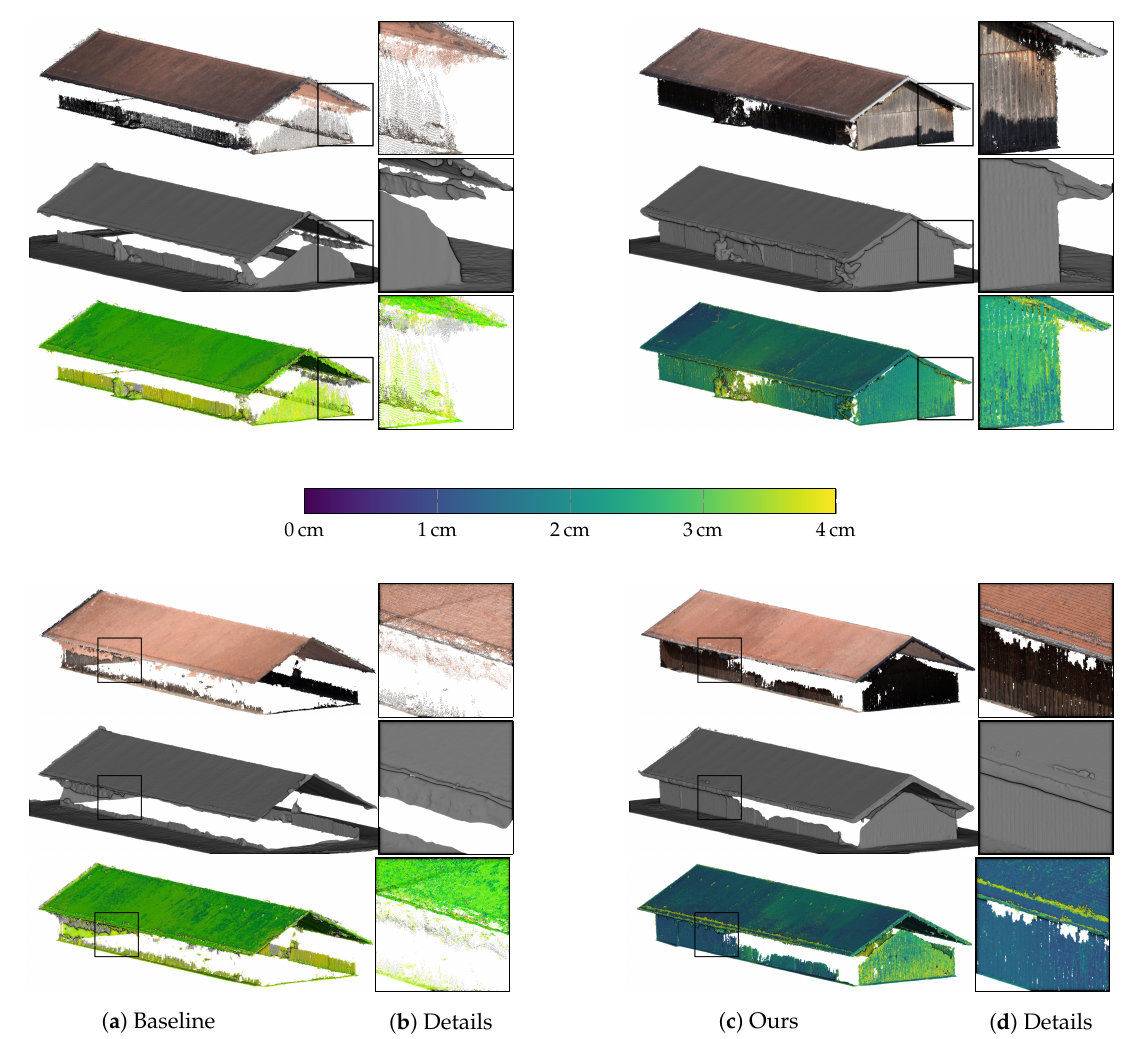
Figure 14. Qualitative reconstruction results for the farm scene using a baseline UAV path ( a ) and our optimized path ( c ). Rows show the densified point cloud ( top ), a triangulated mesh ( mid ) and the point density ( bottom ). Two different viewpoints are visualized which are separated by the colormap of the point density, showing the closest distances between adjacent 3D